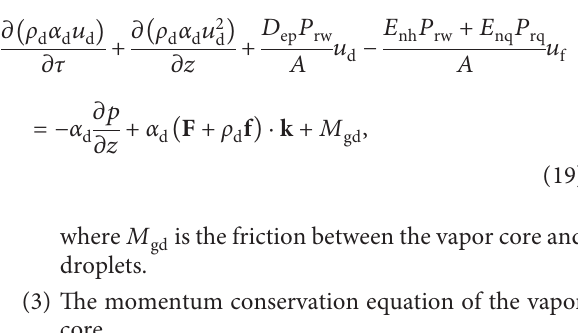
Table 1: Flow regimes and heat transfer